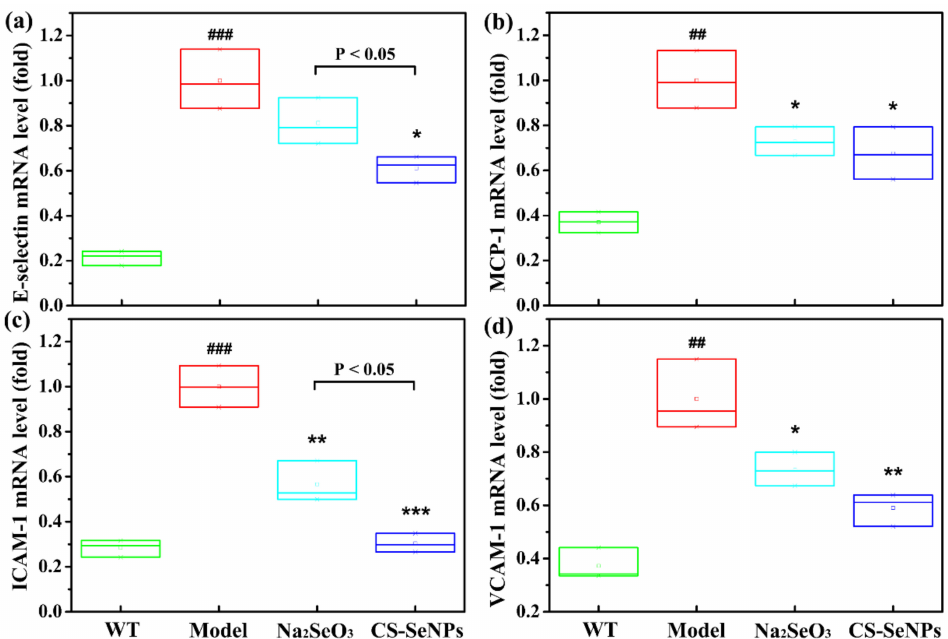
Figure 8. CS-SeNPs and Na 2 SeO 3 attenuated LPS-induced endothelial dysfunction in ECs. Cells were induced with 1 µ g/mL LPS for 12 h alone or pretreated with 0.5 µ M CS-SeNPs or Na 2 SeO 3 for 12 h before exposure to LPS. The mRNA expression levels of E-selectin ( a ) MCP-1 ( b ) ICAM-1 ( c ) and VCAM-1 ( d ) were assayed by qPCR. The results were expressed as mean ± SD ( n = 3). ## p < 0.01, ### p < 0.001, compared with control cells (Con). * p < 0.05, ** p < 0.01, *** p < 0.001, compared with cells treated with LPS alone.